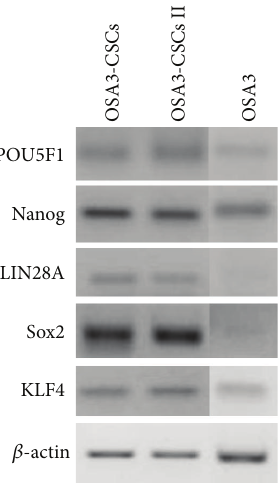
Figure 25: Expression of the nuclear ESC marker genes. RT-PCR show the expression of POU5F1, Nanog, LIN28A, and KLF4 in OSA3-CSCs, in OSA3-CSCs II, and in OSA3.